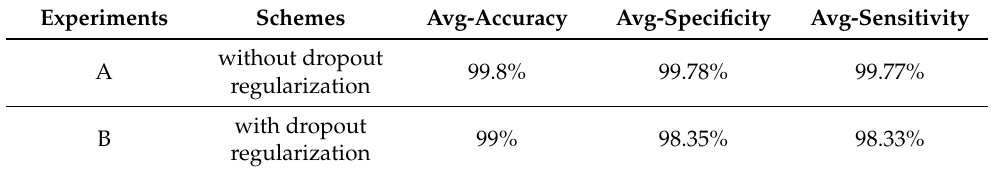
Table 7. Average performance analysis of two experiments for the classification of Arrhythmias.